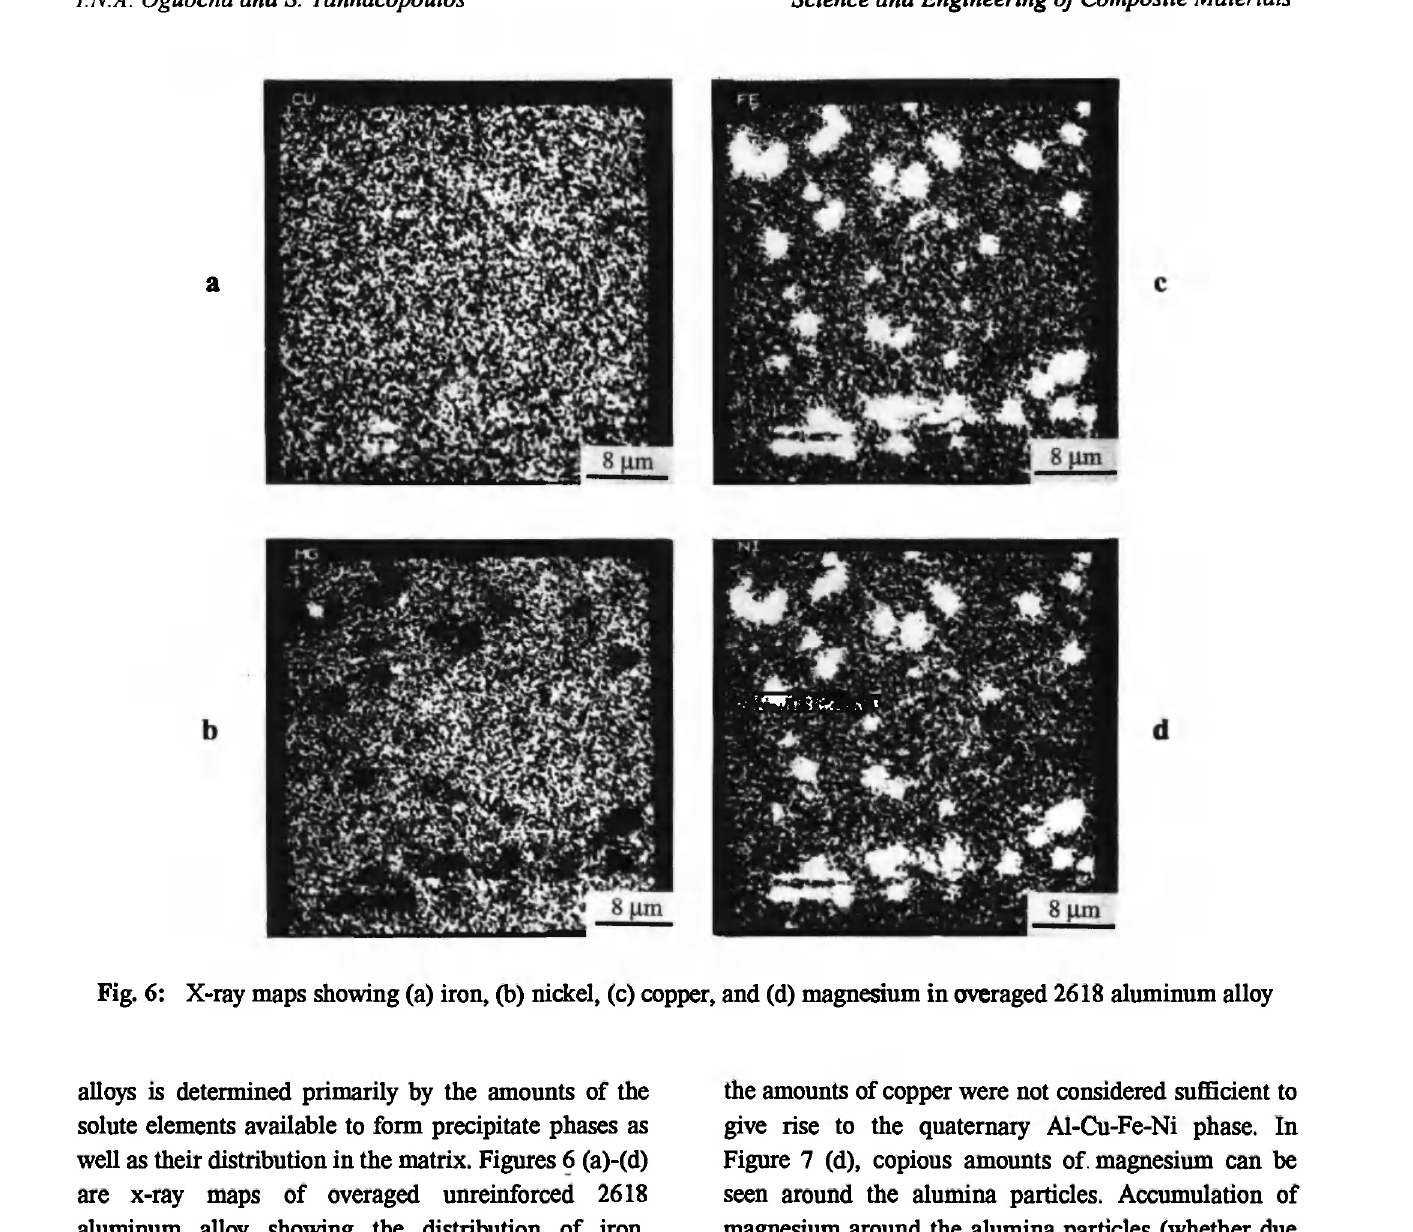
alloys is determined primarily by the amounts of the solute elements available to form precipitate phases as well as their distribution in the matrix. Figures 6 (a)-(d) are x-ray maps of overaged unreinforced 2618 aluminum alloy showing the distribution of iron, nickel, copper and magnesium, respectively. It can be seen that the distribution of iron is similar to that of nickel. This corroborates the EDS results that show that the dispersoid particles are rich in iron and